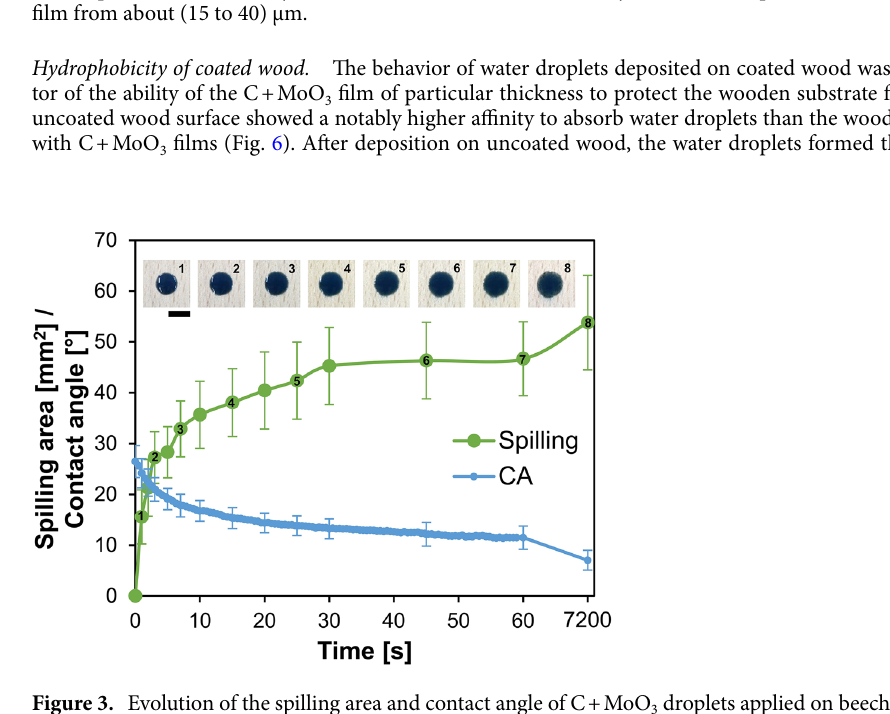
Figure 3. Evolution of the spilling area and contact angle of C + MoO 3 droplets applied on beech wood. The photos are showing the top-view photos of the applied droplets after correspondent time after deposition. The length of the scale bar is 5